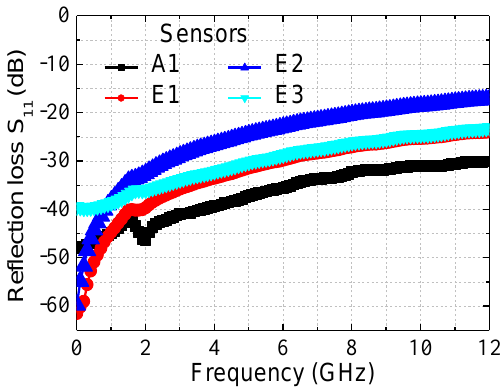
Figure 3. Measured reflection loss S 11 of these n + GaAs/AuGeNi-Au thermocouple-type RF MEMS power sensors.